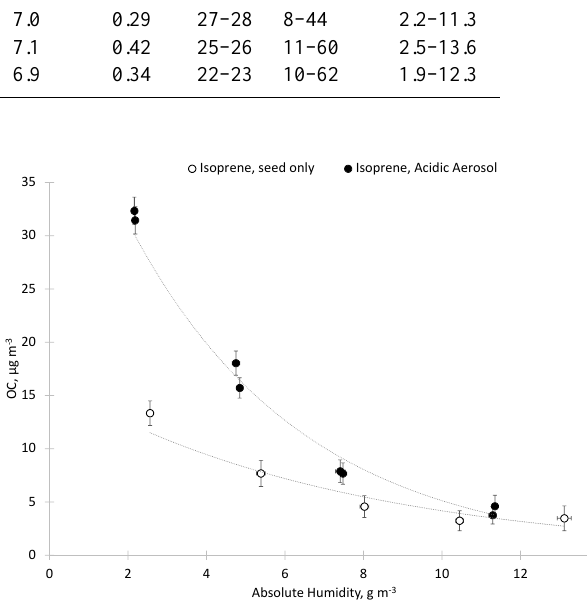
Figure 3. A comparison of the effects of humidity variation on isoprene/NO SOC formation. In ER667 (open circles), only a low-concentration ammonium sulfate seed aerosol was present. In ER662 (closed circles), a moderately acidic sulfate aerosol was gen- erated via